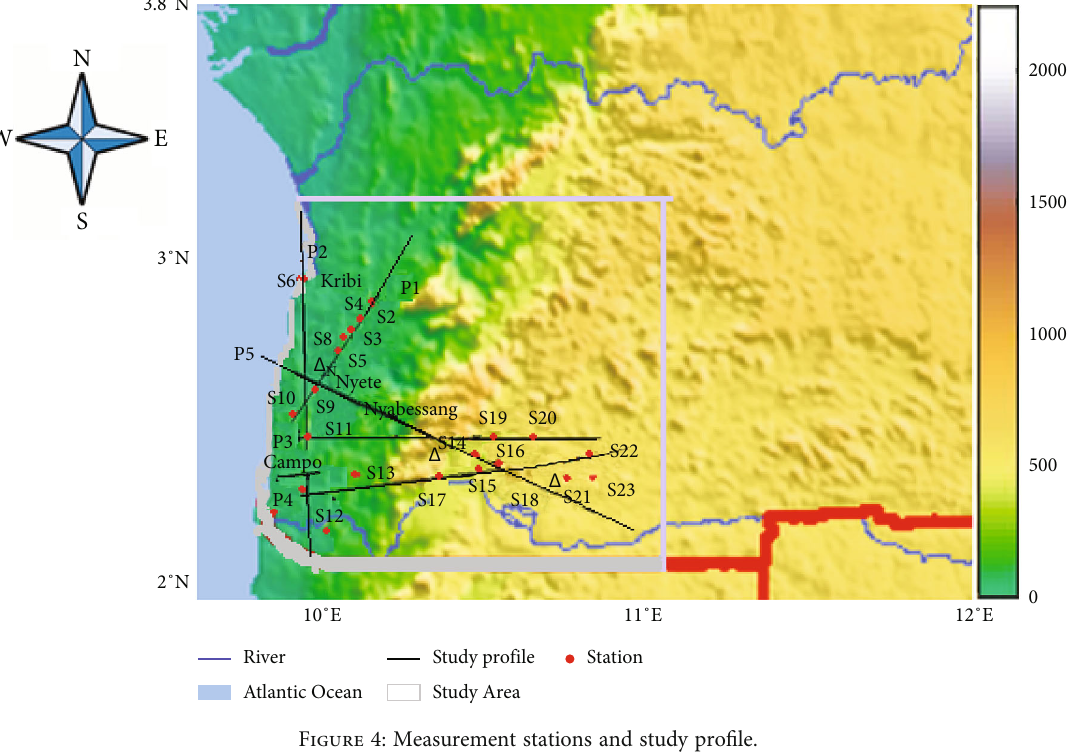
Figure 4: Measurement stations and study pro fi le.